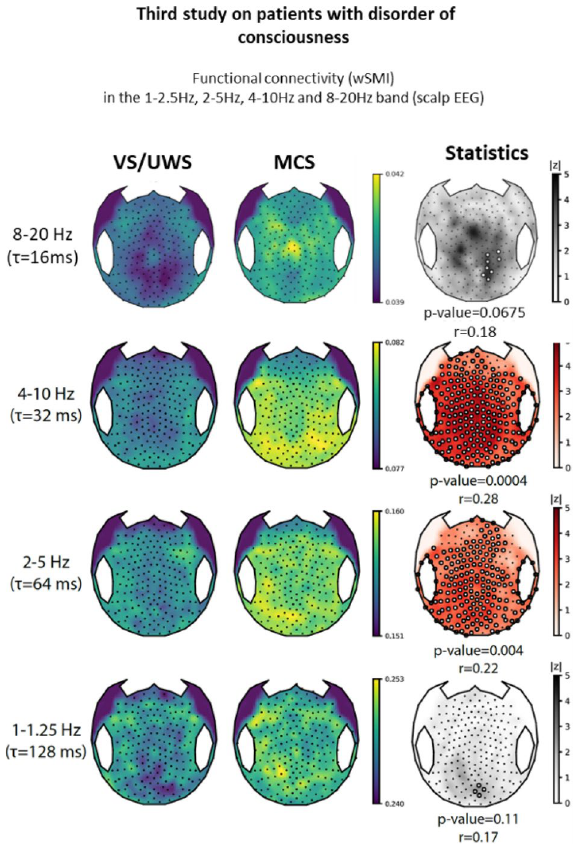
Figure 6. Two-dimensional representation obtained by resuming the value at each electrode by the median value of wSMI between one electrode and all the others for VS/UWS and MCS patients (left columns). This averaging is closely related to the degree measure of a network in graph theory and highlights the sensors that have the strongest connections with other sensors, thus identifying hubs of connections. Results from the permutation cluster-based statistics are represented in the right column. Absolute z-values are plotted with a red color scale when a significant cluster was found and in grey otherwise with the corresponding p-value and effect size r of the cluster. Electrodes belonging to clusters are highlighted by white